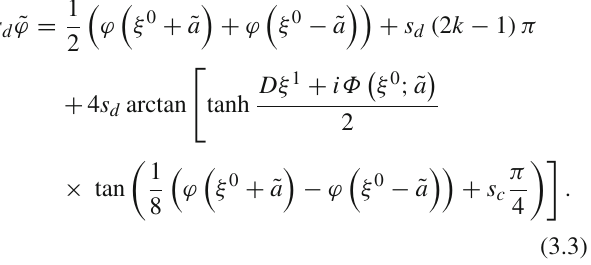
Fig. 3 The dressed solution for a rotating seed with E = 11 μ 2 / 10 and Bäcklund parameter a = 2 at ξ 1 = 0. The dashed lines indicate the (cid:12) (cid:13) ξ 0 ± ˜ a asymptotic behaviour ϕ . The jump due to the kink is